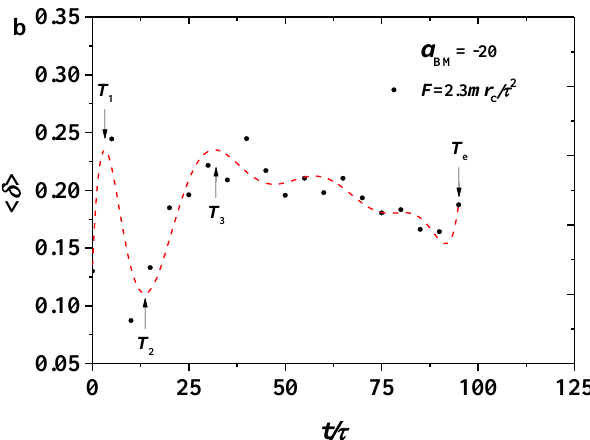
Figure 8. Variation of the shape factor δ for the bottlebrush polymers in the strong adsorption cases of 𝑎 BM = −20 , where the red dotted lines are the fitting results with ( a ) the pulling force of F = 1.7 mr c / τ 2 and ( b ) the pulling force of F = 2.3 mr c / τ 2 , respectively.